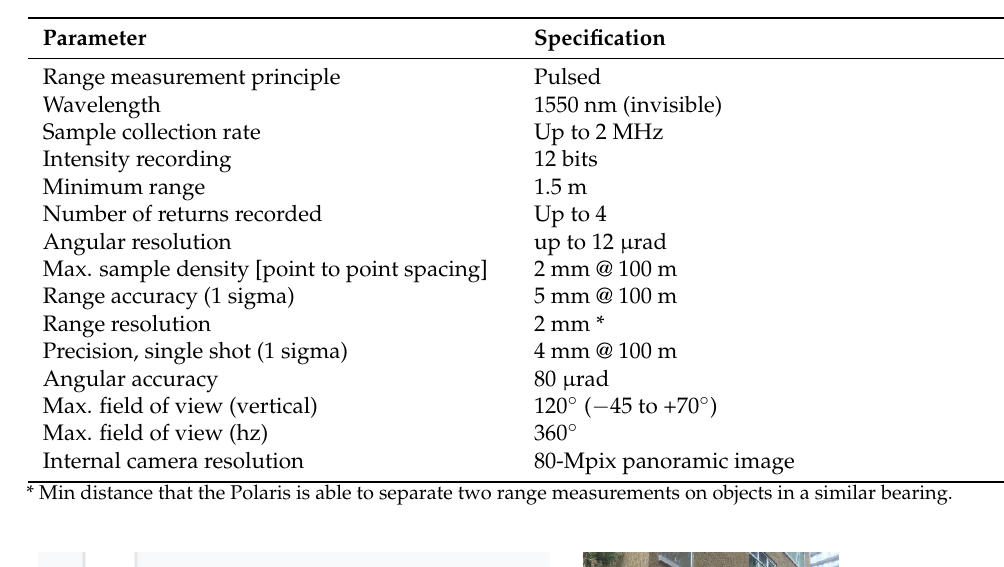
Table 2. Polaris system specifications.